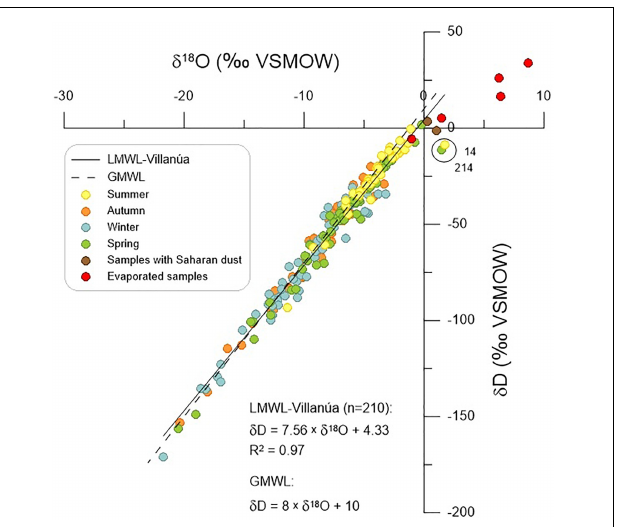
FIGURE 4 | δ D and δ 18 O values of precipitation events in Villanúa. The Local Meteoric Water Line (LMWL) is based on a linear regression through precipitation isotope dataset (black line). Red circles represent samples that suffered evaporation prior to sampling, and they have not been considered for the LMWL. The Global Meteoric Water Line (GMWL) is also indicated (dashed line). Samples enclosed by a circle indicate outliers without evidence of evaporation due to